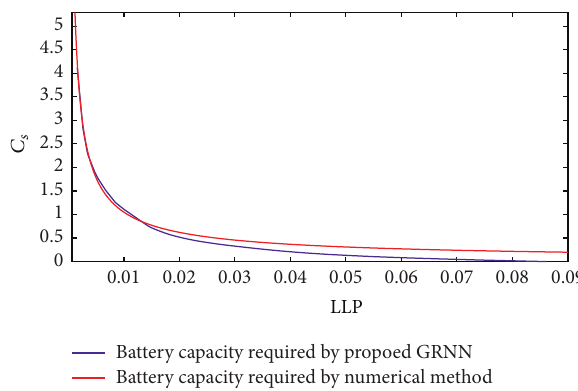
Figure 3: Battery capacity at different LLP.